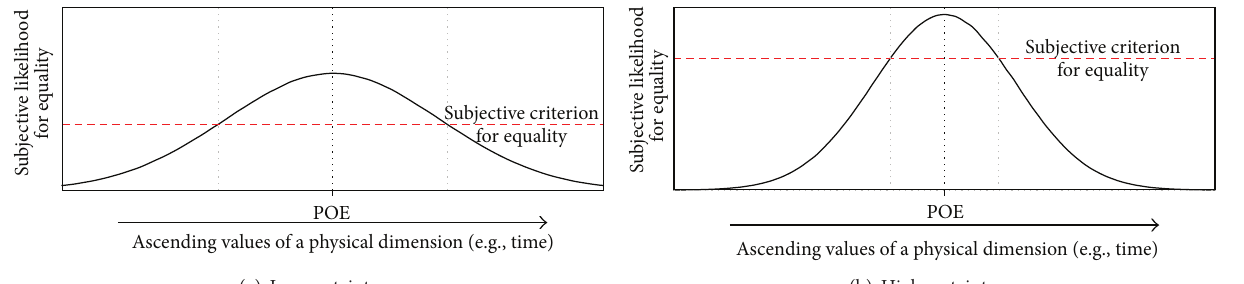
Figure 1: Probability curve for a correct response depending on the elapsed time during the reproduction phase. Increased certainty (b) should result in a sharpening of the curve and in a more restrictive criterion level, thereby attenuating the degree of